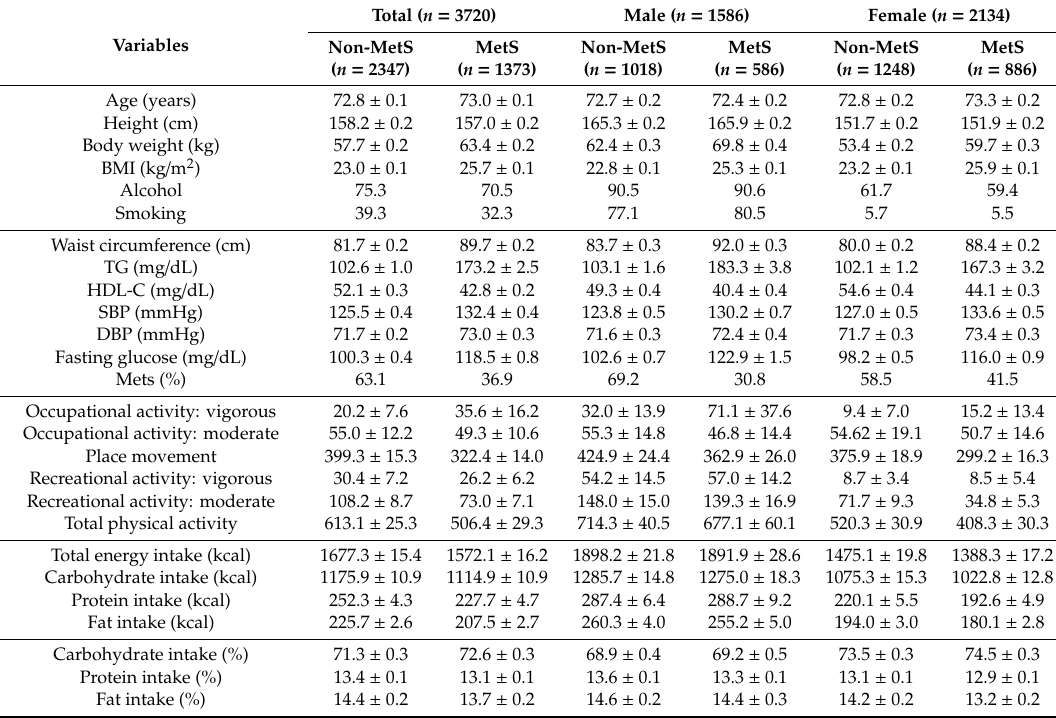
Table 1. Descriptive characteristics of the